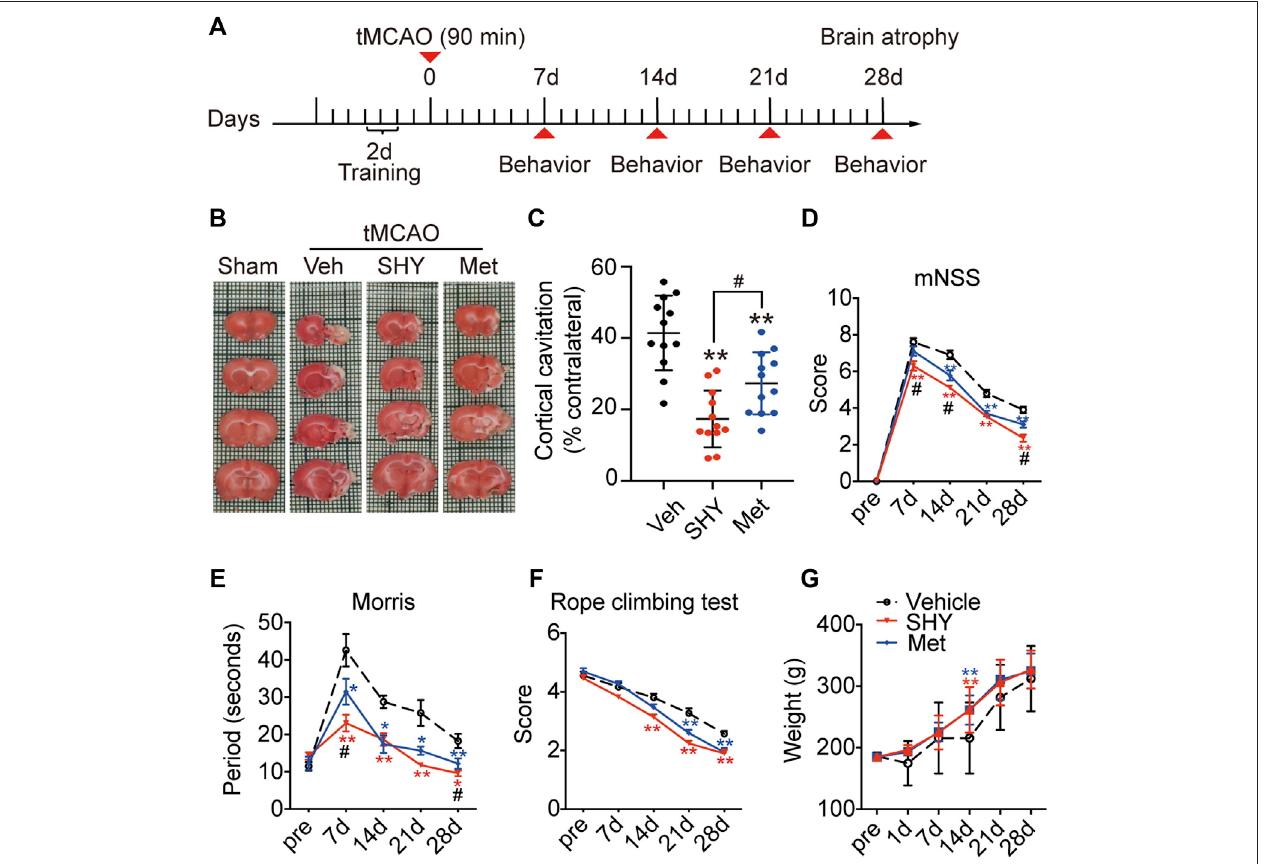
FIGURE 8 | SHY-01 promotes long-term functional recovery of rats with tMCAO. SHY-01 (SHY, 50 mg/kg/day) or metformin hydrochloride (Met, 50 mg/kg/day) was administrated ( i.p. ) every 24 h post reperfusion, saline was used as vehicle control, rats were sacri fi ced at 4 weeks after tMCAO. (A) Timeline of SHY or Met treatments during neurologic recovery over the period of 4 weeks post-stroke. (B) Representative images of rat brain sections stained with TTC. (C) Brain atrophy was quanti fi ed, and (D) neurologic scores were analyzed in each group. n = 12 rats/group, data are expressed as mean ± SD, statistical analysis was performed with one-way ANOVA, followed by a Dunnett ’ s post hoc tests. pp p < 0.01 versus tMCAO treated with vehicle group; # p < 0.05, versus tMCAO with SHY-treated group. Behaviorsof (E) Morriswatermazetestand (F) ropeclimbingtestwereevaluated, (G) weightchangeswererecordedfor4weekspost-ischemia.Resultsareexpressed as medium ± SEM ( n = 8/group). Statistical analysis in each time point was performed by statistical analysis was performed with one-way ANOVA, followed by a Dunnett ’ s post hoc tests. p p < 0.05, pp p < 0.01 versus vehicle group; # p < 0.05 versus SHY-treated